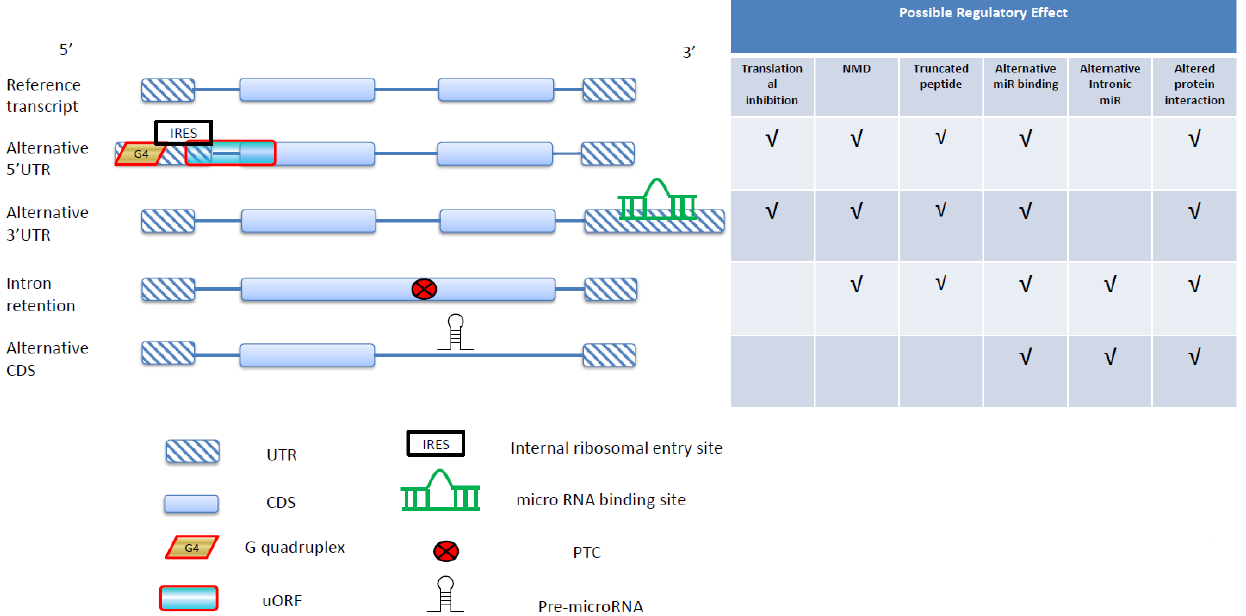
Figure 2. An overview of alternative RNA structure-coupled gene regulations. Four possible types of alternative RNA structure are listed (alternative 5'UTR, alternative 3'UTR, intron retention, and alternative CDS). The possible regulatory outcomes of the alternative RNA structures are shown in the table on the right